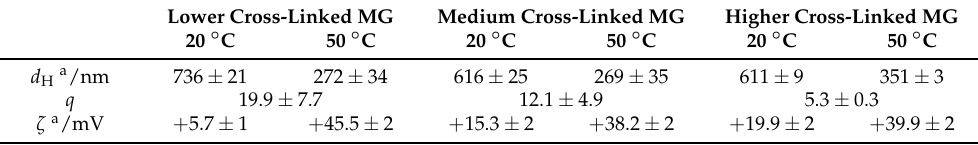
Table 2. Measured properties of the used MG